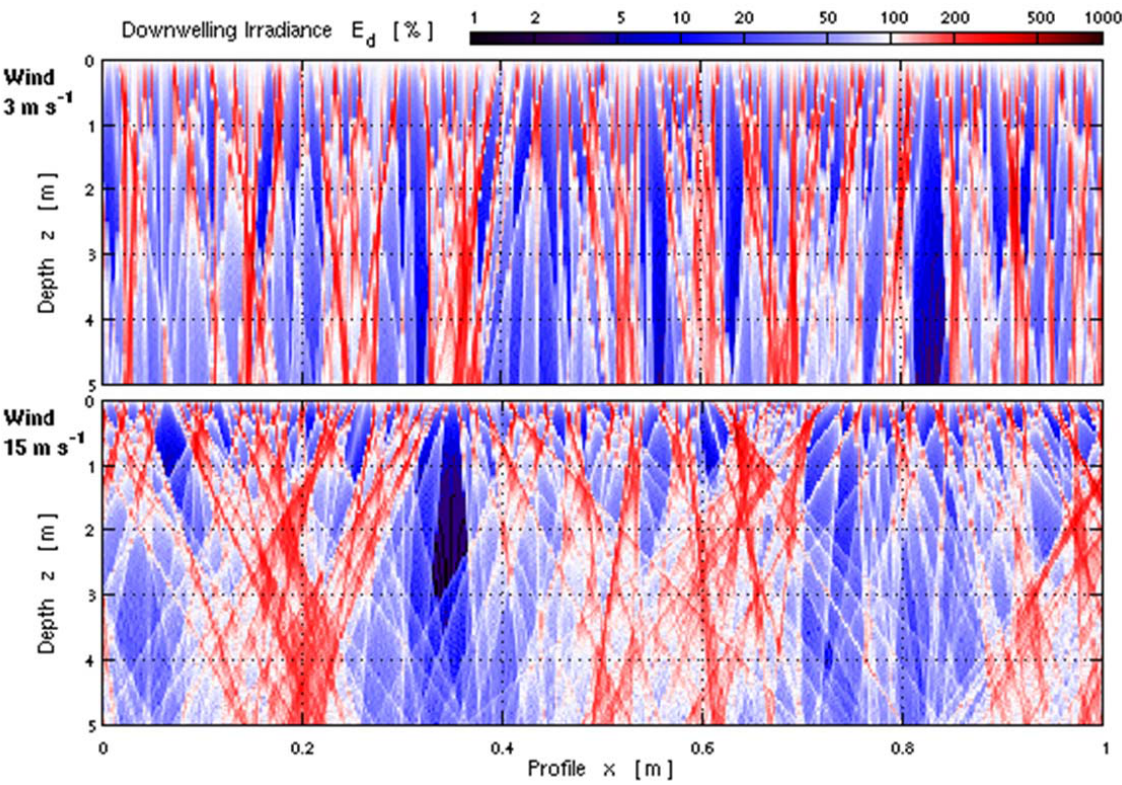
Fig. 4. Spatial distribution of the downwelling irradiance E d due to local wind speeds of 3 and 15ms − 1 that are simulated with the near- Fig. 4 : Spatial distribution of the downwelling irradiance E surface model with dx = 2.5mm, E d above the surface is 100% (logarithmic colour of 3 and 15 m s ‐ 1 that are simulated with the near ‐ surface model with dx = 2.5 mm, E the surface is 100 % (logarithmic color scale). 5